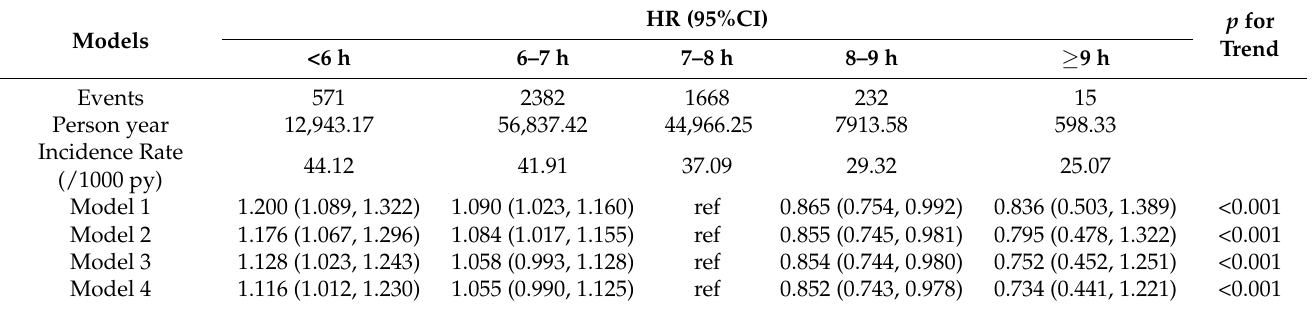
Table A2. Sensitivity analysis in association of five sleep duration groups with risk of